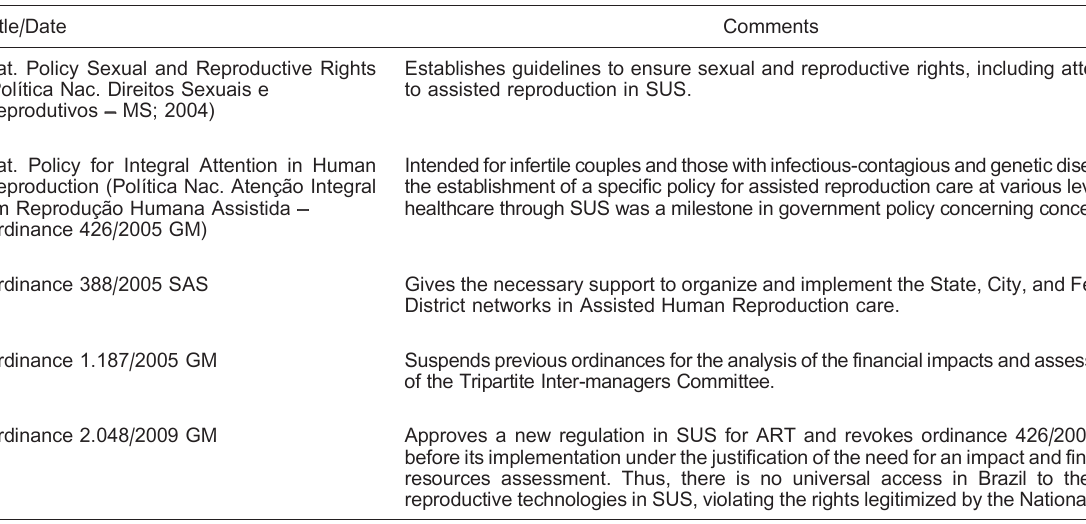
Table 1. Public policies aimed at assisted reproduction techniques (ART) with respect to hereditary genetic diseases in